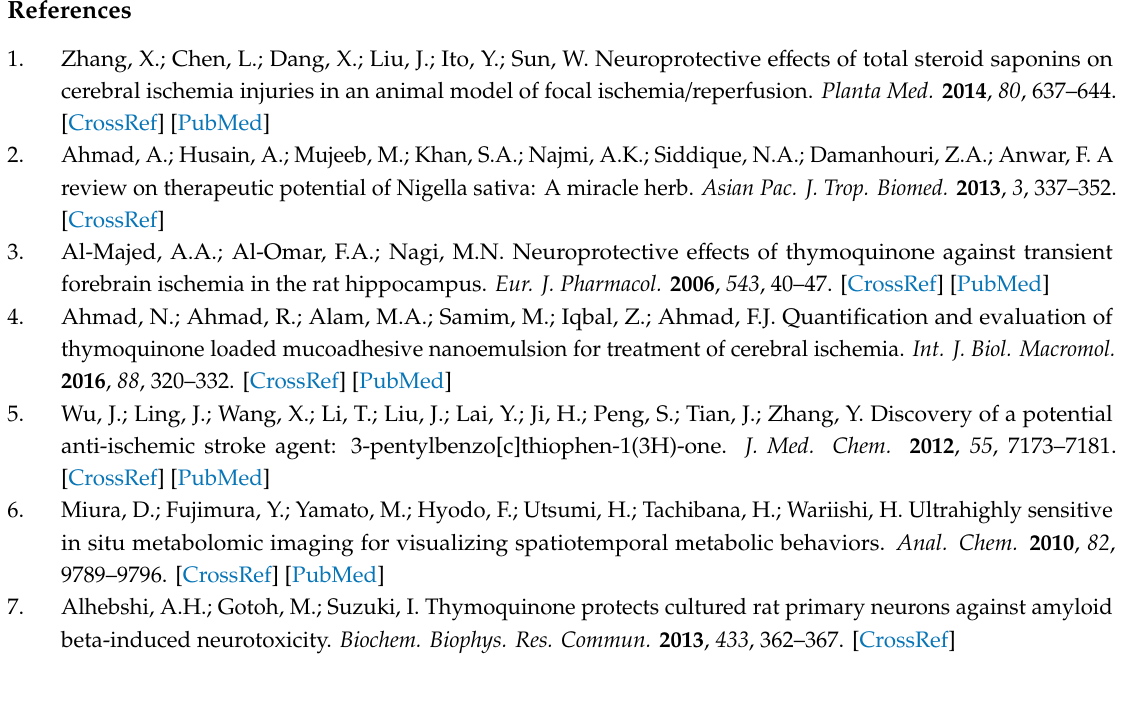
Figure S1: Negative ion mode mass spectrum of aerobic oxidation-related molecules and amino acids using a 1,5-DAN hydrochloride matrix, Figure S2: Negative ion mode mass spectrum of energy metabolism-related molecules using a 1,5-DAN hydrochloride matrix, Figure S3: Negative ion mode mass spectrum of phospholipid molecules using a 1,5-DAN hydrochloride matrix, Figure S4: Negative ion mode mass spectrum of other metabolic molecules using a 1,5-DAN hydrochloride